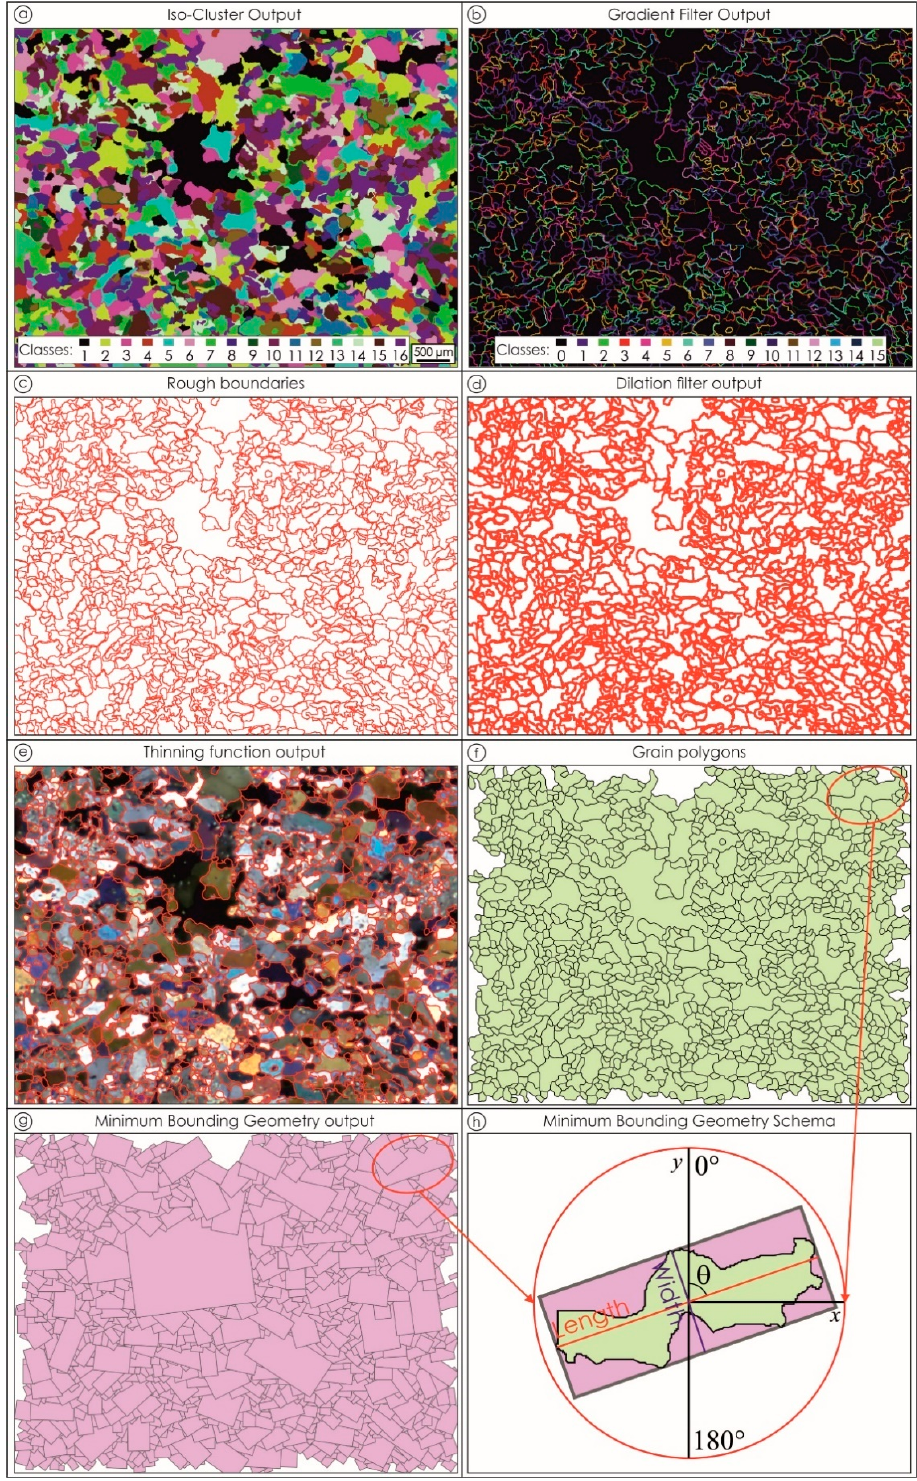
Figure 4. GSD tool filtering and vectorization steps: ( a ) the output of the iso-cluster algorithm by choosing 16 classes; ( b ) the output of the gradient filter; ( c ) the extraction of rough boundaries; ( d ) the output of the dilation filter; ( e ) the output of the thinning function placed on the thin section; ( f ) the map of the digitized polygons representing rock-forming grains; ( g ) the output of the Minimum Boundary Geometry (MBG) algorithm; ( h ) schematization of the measurements collected through the MBG. Length and width represent, respectively, the long and short axis of the grain, whereas θ is the angle, measured clockwise, between the vertical direction (y) and the length of the grain ( θ = 71 ◦ in the